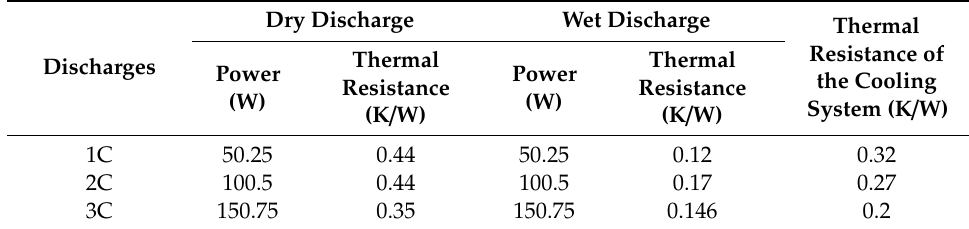
Table 7. The thermal resistance of battery module during the dry and wet 1C, 2C and 3C discharges, as well as the thermal resistance of cooling